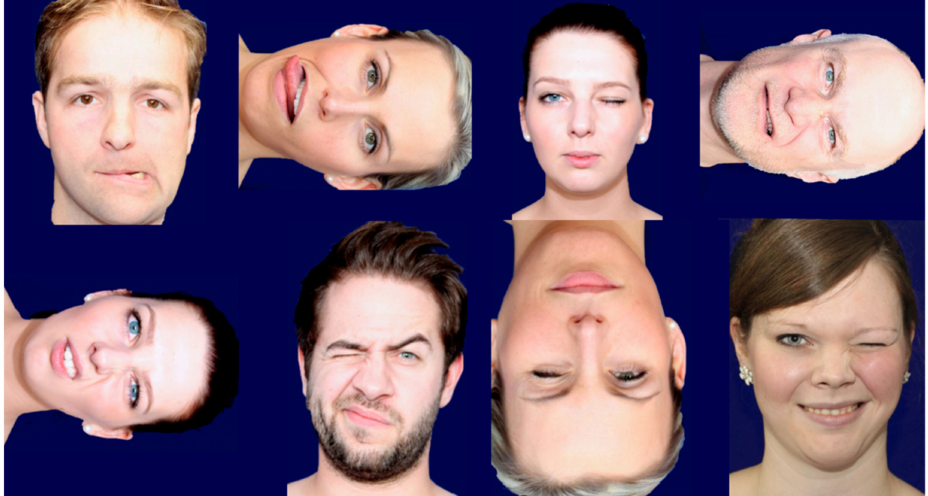
Figure 3. Left/right judgement is a task identifying randomized pictures where the model activates the eye, tongue, eyebrow or jaw as moving on or towards either the left or right side in a rotated position of 0 ◦ , 90 ◦ , 180 ◦ or 270 ◦